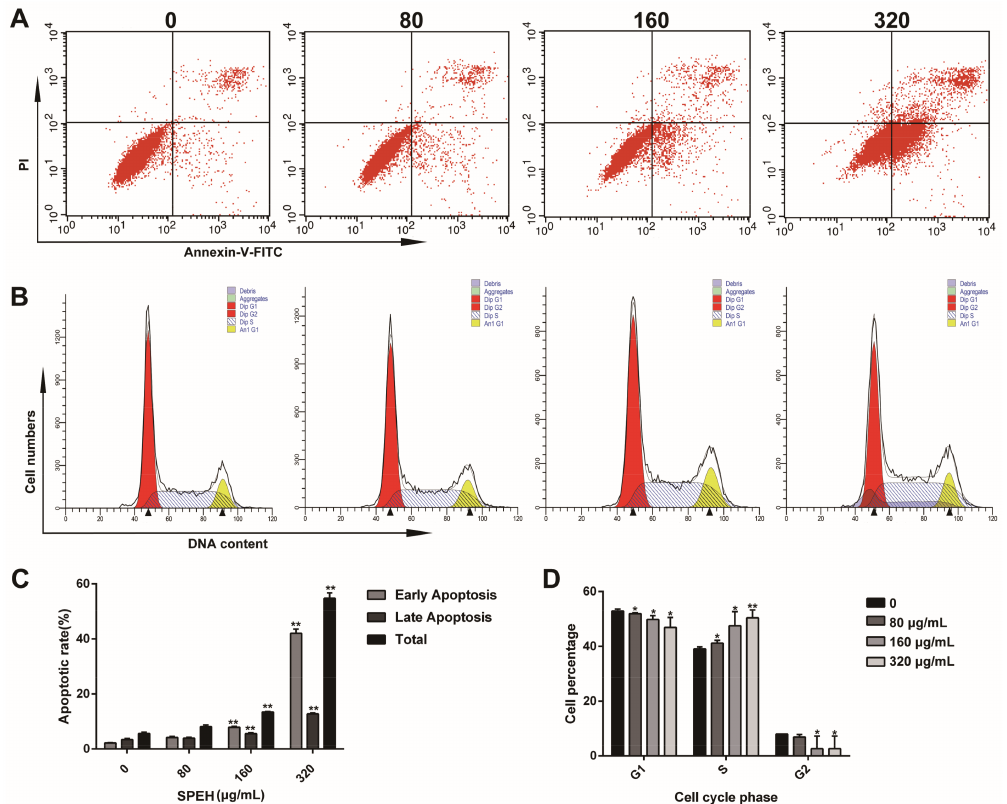
Figure 3. SPPH induces apoptosis and cell cycle arrest of SGC-7901 cells. ( A ) SGC-7901 cells were treated with SPPH for 36 h and labeled with Annexin V and PI to conduct flow cytometric assay; ( B ) SGC-7901 cells were stained with propidium iodide (PI) and subjected to flow cytometric assay; ( C , D ) Quantitative analysis for the cell apoptosis and cell cycle distributions, respectively. Data are expressed as Mean ± SD ( n = 3). ** p < 0.01 versus control, * p < 0.05 versus